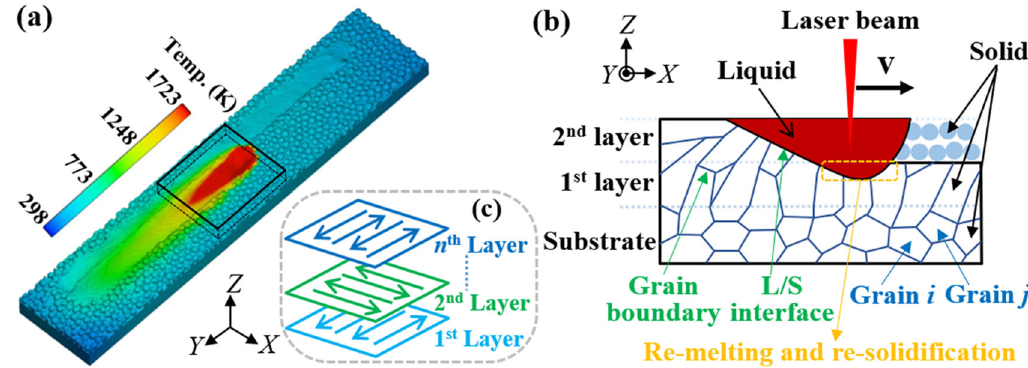
Fig. 10 Schematic diagrams for SLM process simulation. a Temperature fi eld calculated by the TFF model; b liquid/solid phases and grain morphologies under the temperature pro fi le; c scanning path.The black box in a shows the simulated PF region inside the whole domain of the TFF